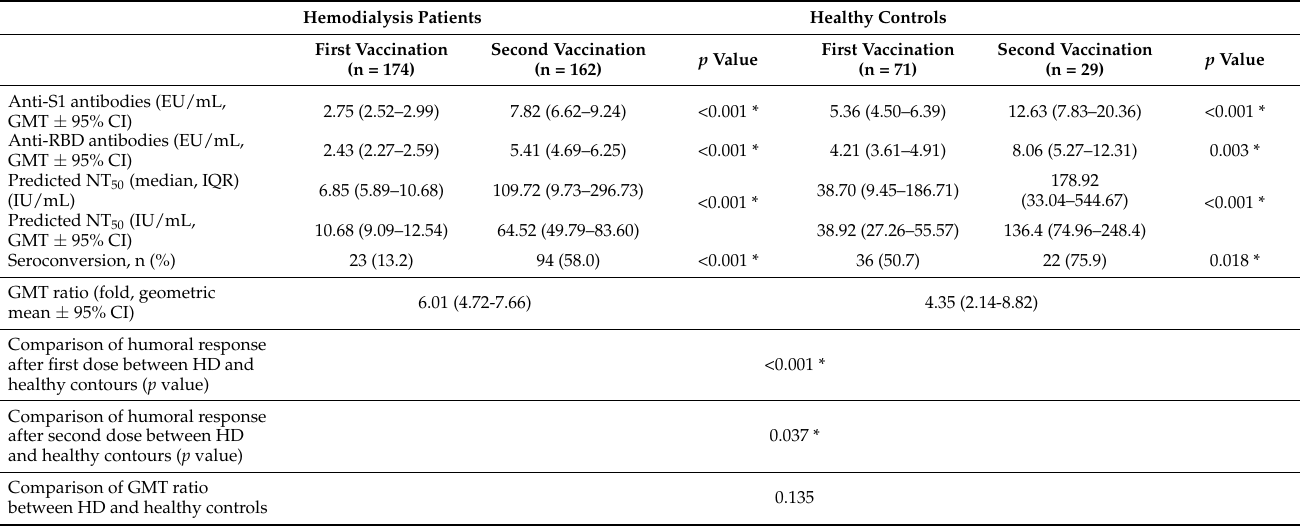
Figure 4. Individual NT 50 courses in all and in age-matched individuals after the first and after the second ChAdOx1 vaccination are illustrated ( a , b ), respectively. Table 5. Humoral responses evolution of prime-booster vaccination of ChAdOx1 (Oxford – Astra- Zeneca).